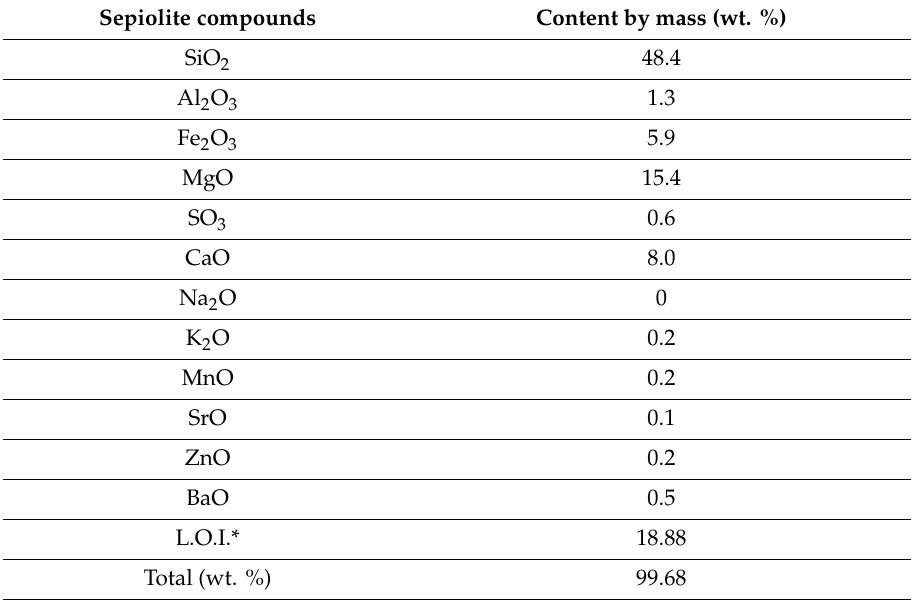
Table 1. XRF analysis of sepiolite from Tanbo region in Iran.